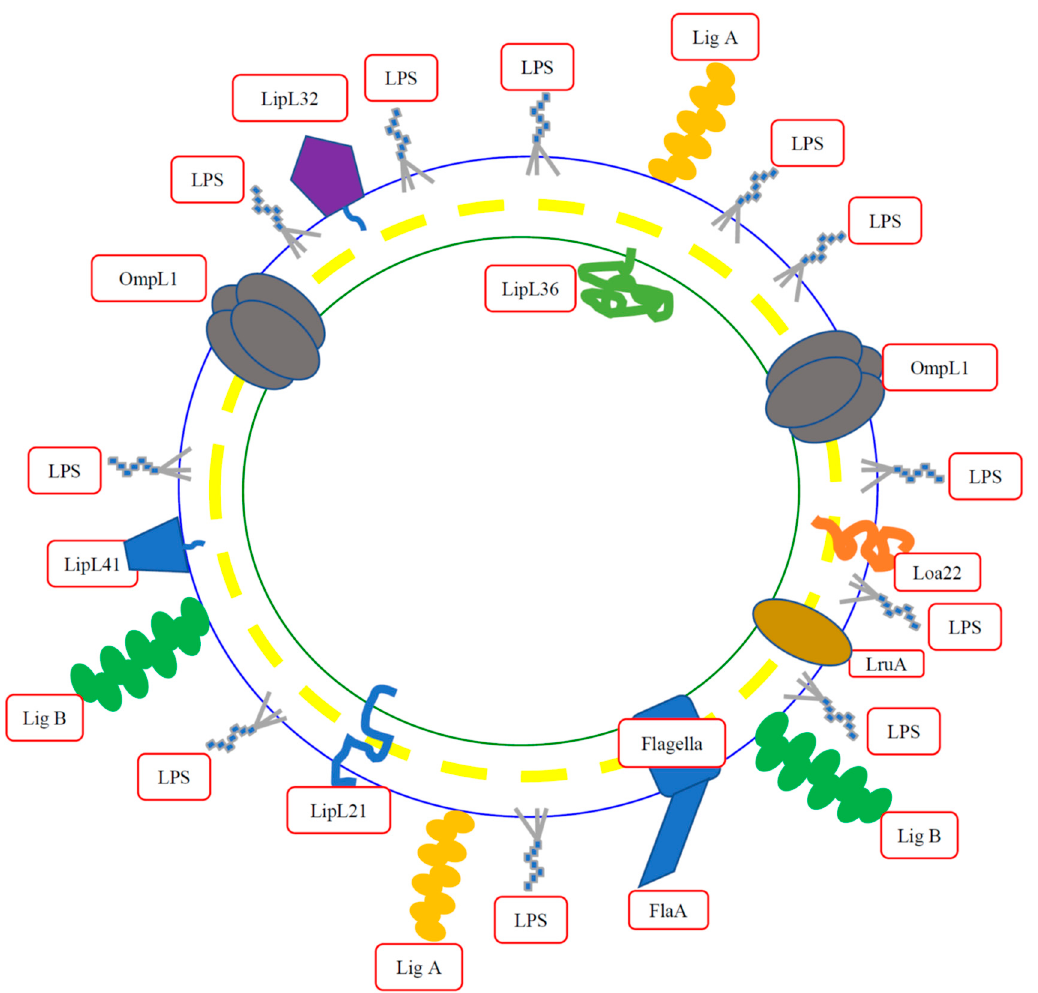
Figure 1. Leptospira membrane components. Leptospria membrane is a double membrane structure and it is the first line to contact with the host cell and many outer membrane components may act as virulence factors. The virulence factors evaluated by genes manipulation (including LPS, LipL32, Loa22, LipL41, LruA, LigA, LigB, and LipL21) will be selected to discuss in this review for the virulence mechanism investigation. Blue circle, outer membrane; yellow circle, cell wall; green circle, inner membrane.